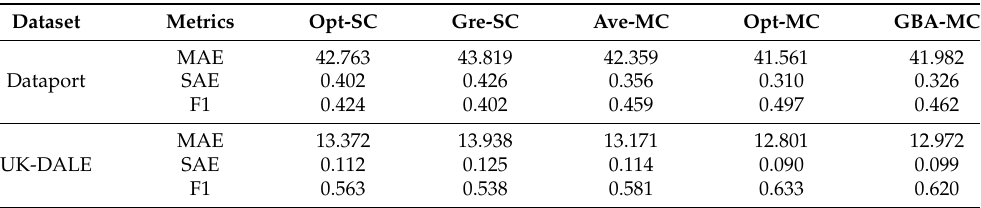
Table 3. Performance of different methods on different datasets.